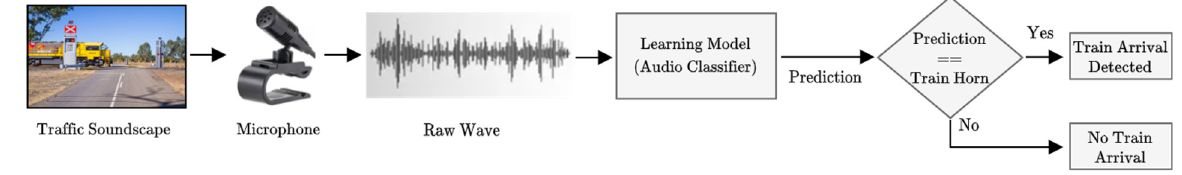
Figure 1. The general structure of the TH-TAD system.